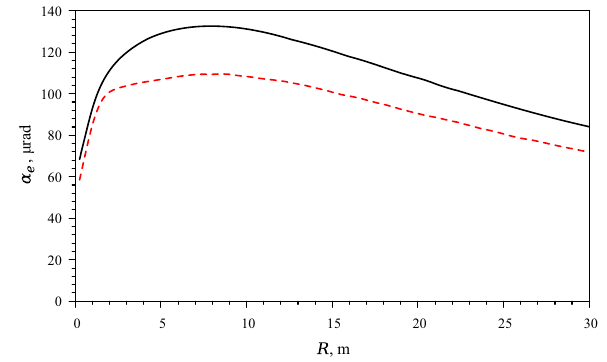
Fig. 3 Dependenceofthedeflectionangle α e ontheradiusofcurvature for the crystal orientation along the (cid:2) 110 (cid:3) axis (black solid line) and along the (cid:2) 111 (cid:3) axis (red dashed line) with respect to the impinging particles